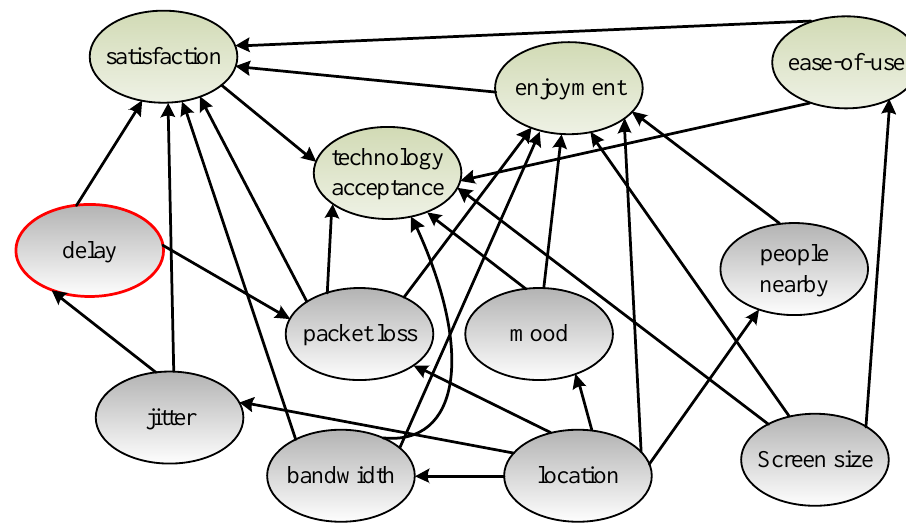
Figure 4. The scheme of connections between the factors influencing customer satisfaction.